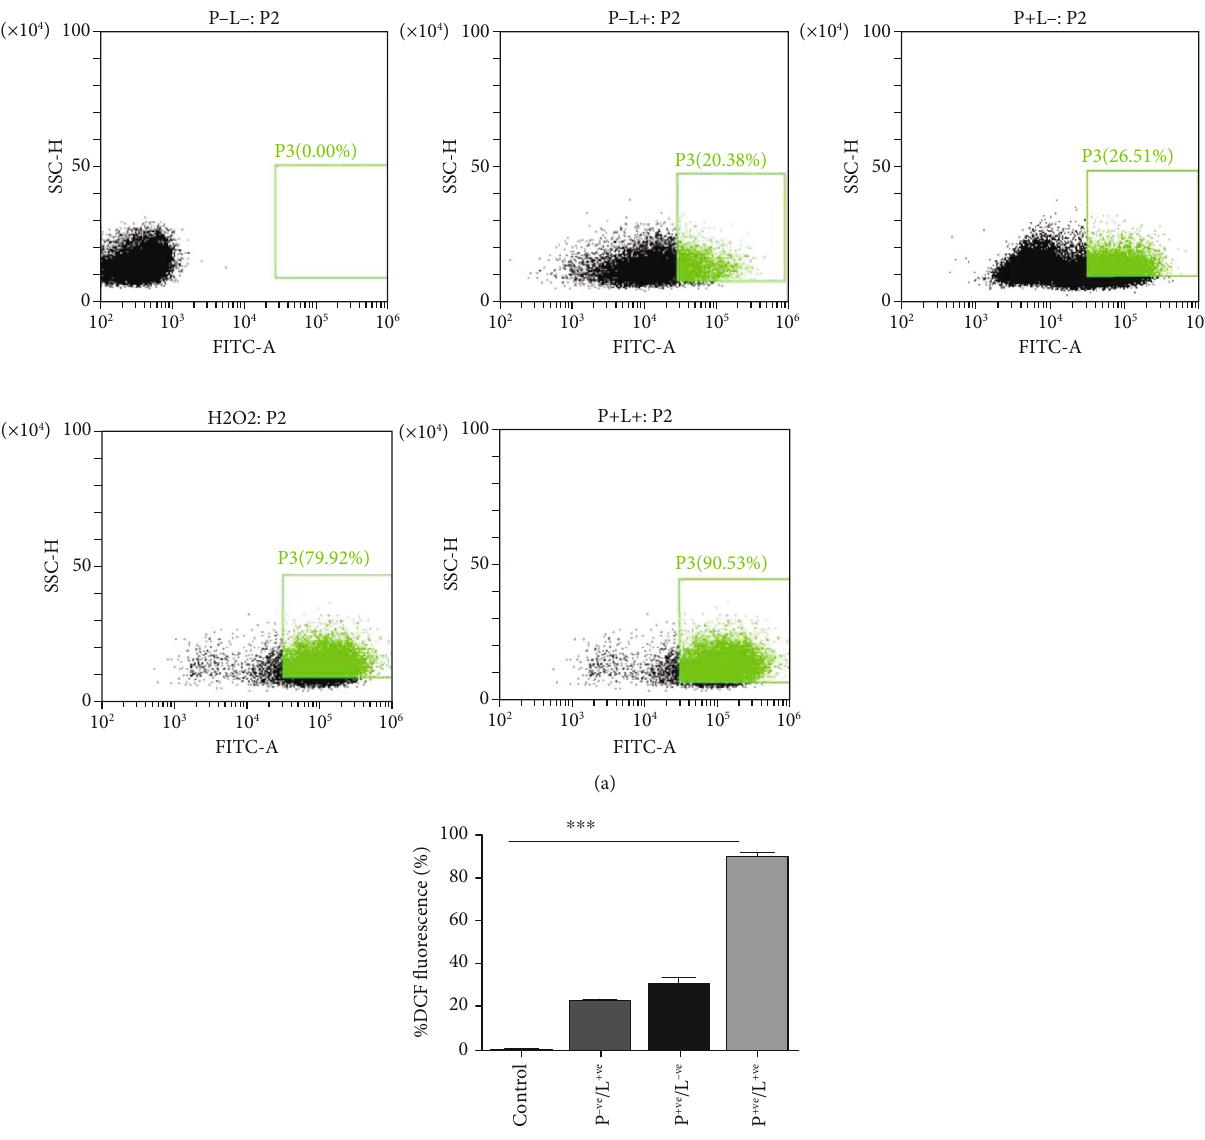
Figure 7: AE-mediated PDT induced intracellular ROS in TE 354.T cells. (a) Untreated cells (P-L-), light-treated cells (P-L+), AE-treated cells (P+L-), H O -treated positive control cells (H 2 2 percentage fl uorescence. Results are expressed as means ± SD from three independent